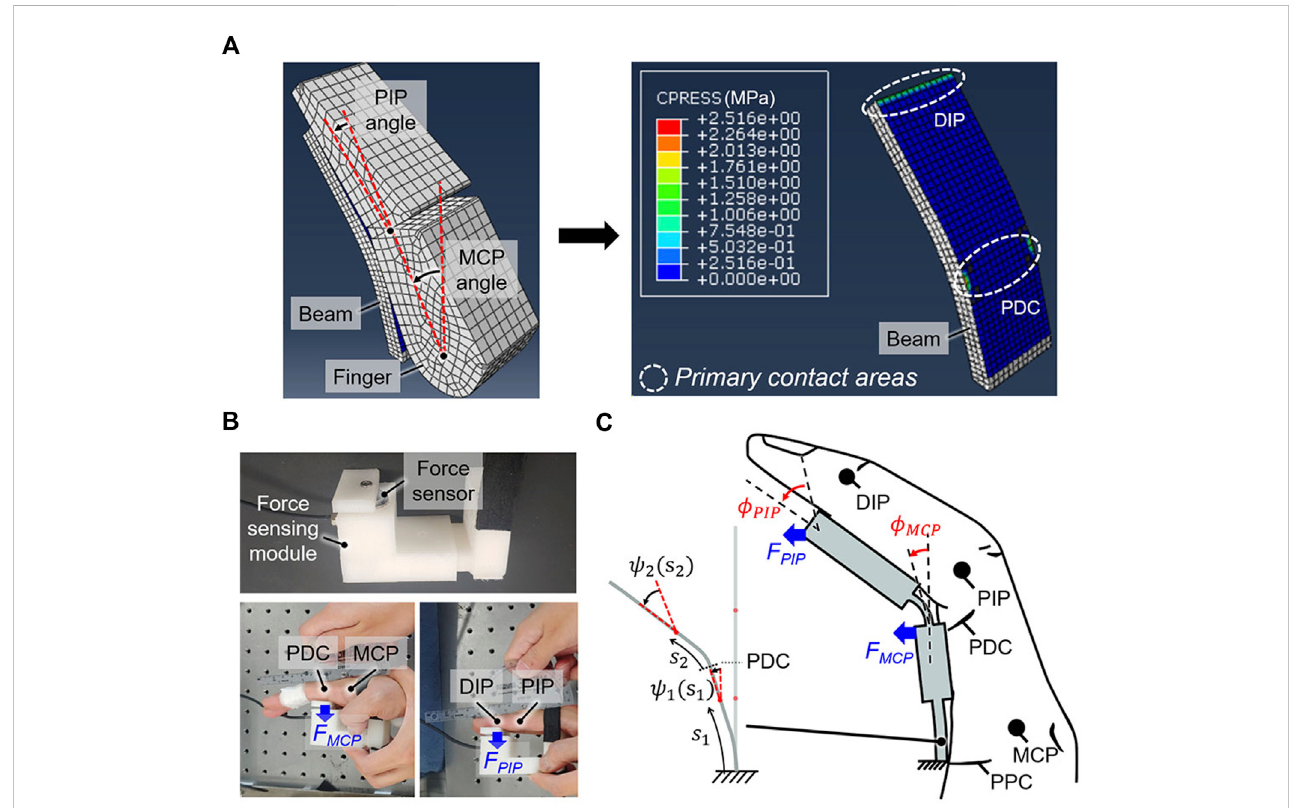
FIGURE 5 Obtaining the stiffness solutions of the beam to achieve passive extension. (A) The contact pressure is concentrated at the primary contact areas, which arelocatednearthePDCandDIPwhenthe fi ngeris fl exedagainstthebeamtoachieveatargetgripapertureof80 mm. (B) Thejointresistiveforces( F MCP , F PIP ) attheprimarycontactareas,whicharerespectivelyappliedtoextendtheMCPandPIPjoints,weremeasuredusingaforcesensor. (C) Calculatingthestiffness solutionsforwhichthebeamde fl ectionangles( ψ 1, ψ 2 )attheprimarycontactareasequaltheindividuallymeasuredjointangles( ϕ MCP ; ϕ PIP )foryieldingan 80-mm grip aperture. The stiffness solutions were obtained based on the coordinates ( s 1 , s 2 ) of each beam segment, which were divided by the position of the